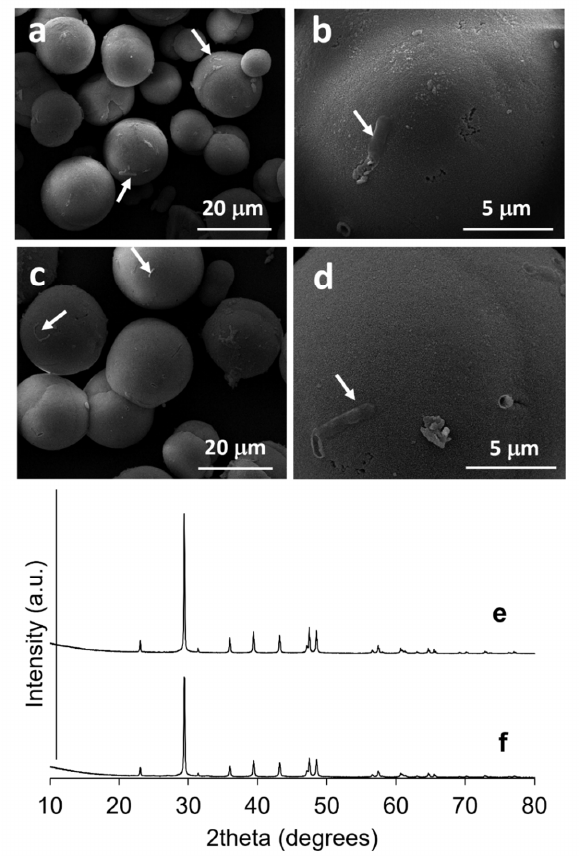
Figure 6. SEM images and XRD spectra of CaCO 3 particles precipitated in the culture broth of L. fusiformis 5.1 ( a , b , e ) and L. xylanilyticus 4.3 ( c , d , f ) after addition of 0.4 M CaCl 2 . Arrow shows bacterial cells.